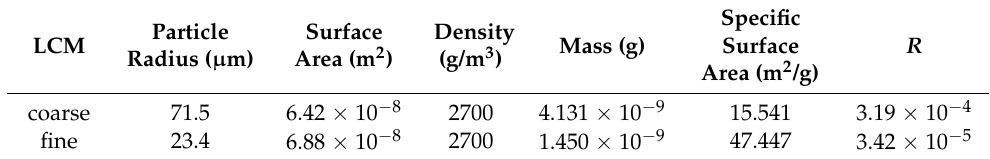
Table 9. Comparison of coarse and fine LCM.